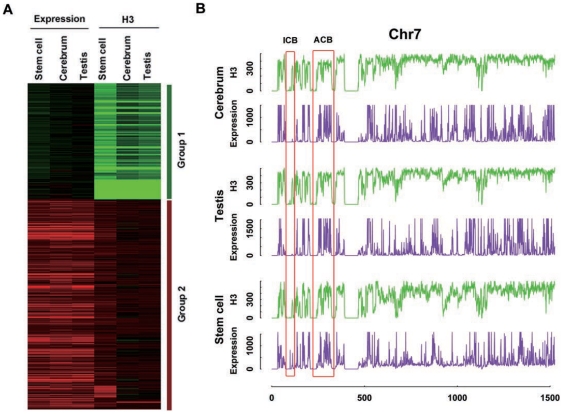
Clustering of nucleosomal and transcriptional features (A) and an example to illustrate actively-transcribed chromosomal blocks (ACB) and inactively-transcribed chromosomal blocks (ICB) (B).The NO signals and sequence tags from rmRNA-seq are aligned in a 100-kb window (the tag densities from high to low are scaled from red to green). Criteria about the grouping scheme (Group1 and Group2) are discussed in the main text and they are corresponding to LOG and HOG. We observed large genomic regions where NO intensity and transcriptional activity are constantly low (ICB) or high (ACB), and examples are highlighted in red boxes.